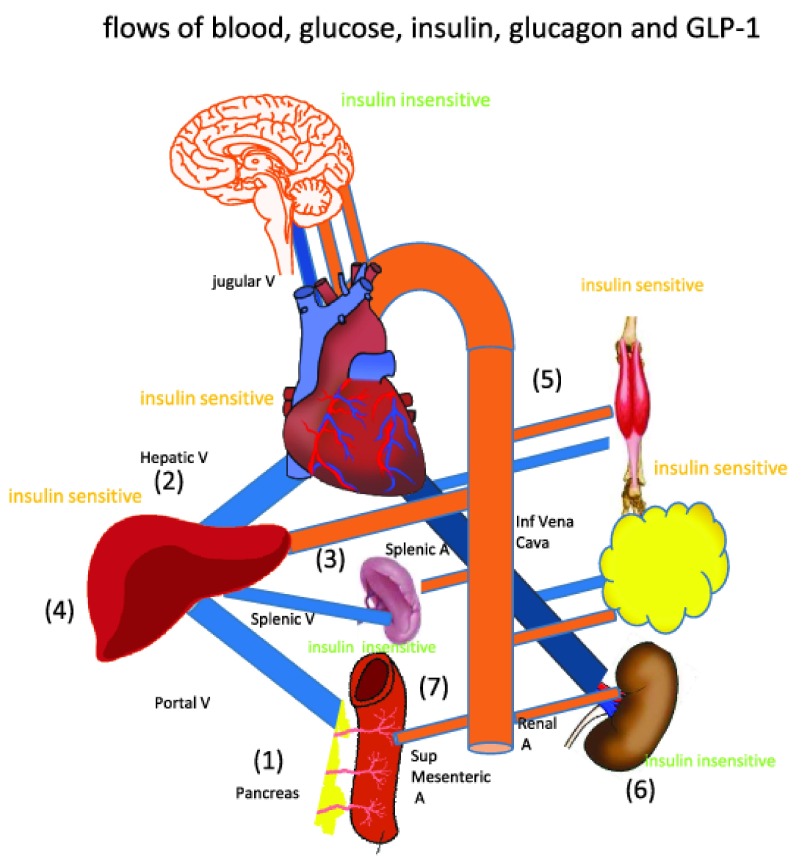
Diagram outlining splanchnic and systemic blood flows.